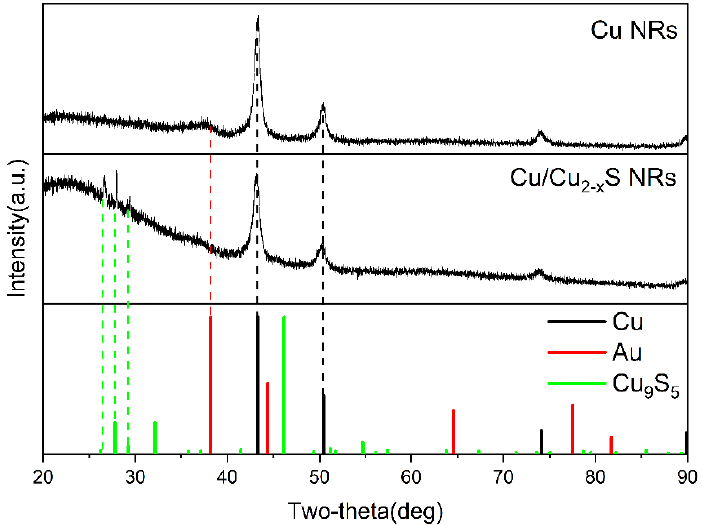
Figure 6. XRD patterns of Cu NRs before and after sulfidation. The bottom column diagram represents the standard diffraction pattern of Cu (#85-1326), Au (#04-0784), and Cu 9 S 5 (#47-1748).